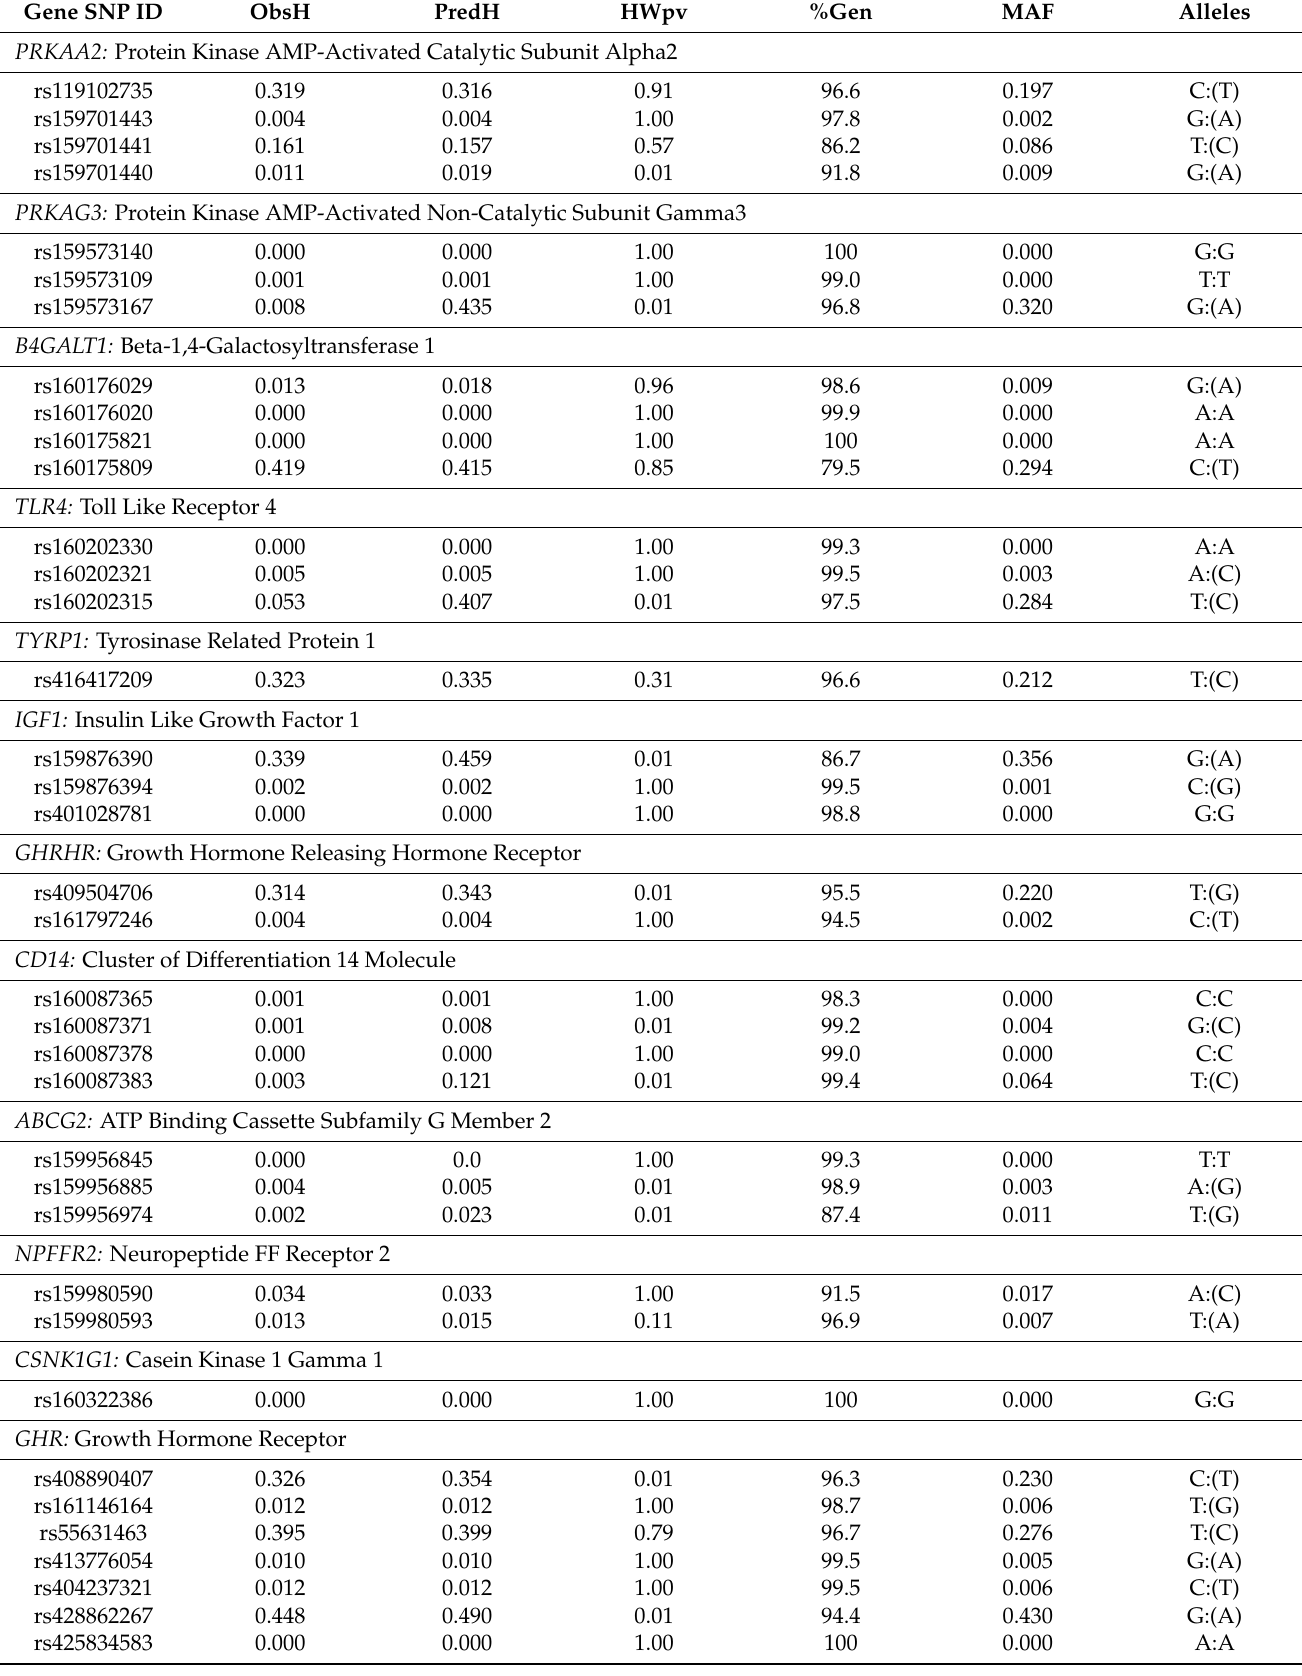
Table 1. The variability of 45 SNPs genotyped in Sarda sheep ( n =